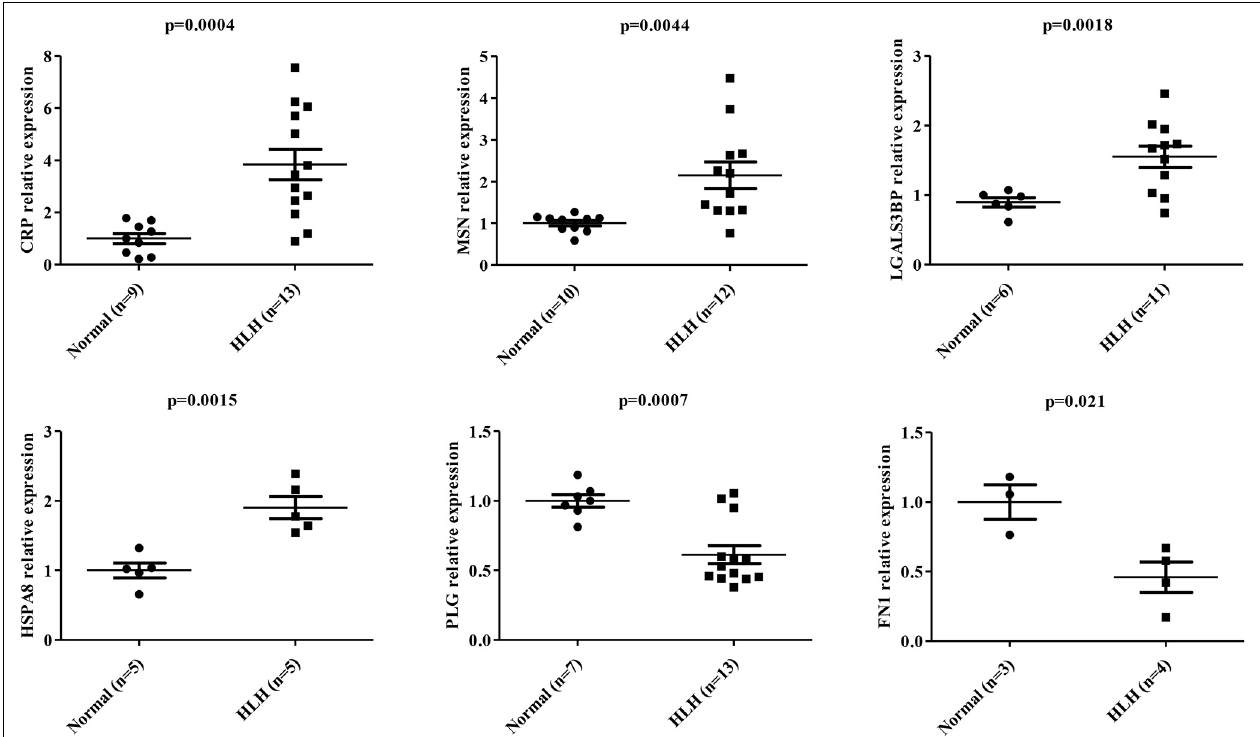
FIGURE 6 | Statistical analysis of differentially expressed protein levels in plasma exosomes obtained from other patients with EBV-HLH. Gray value statistical analysis of differentially expressed protein levels of plasma exosomes between healthy controls (N) and other patients with EBV-positive HLH (H). A t -test was used to test the differences between